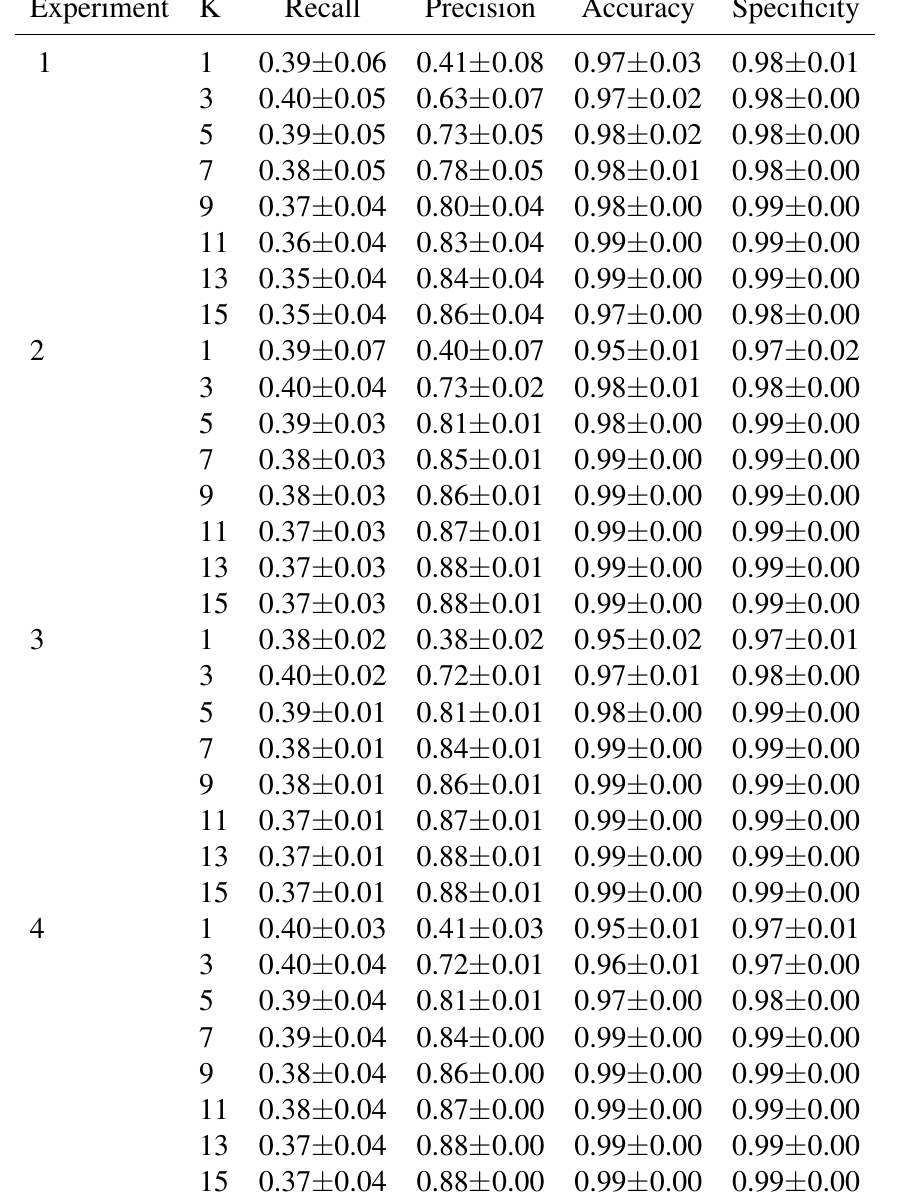
Table 4: Study of the number ( K ) of prediction vectors at 8 ˚A of distance threshold ( (cid:22) (cid:6) (cid:27) values).